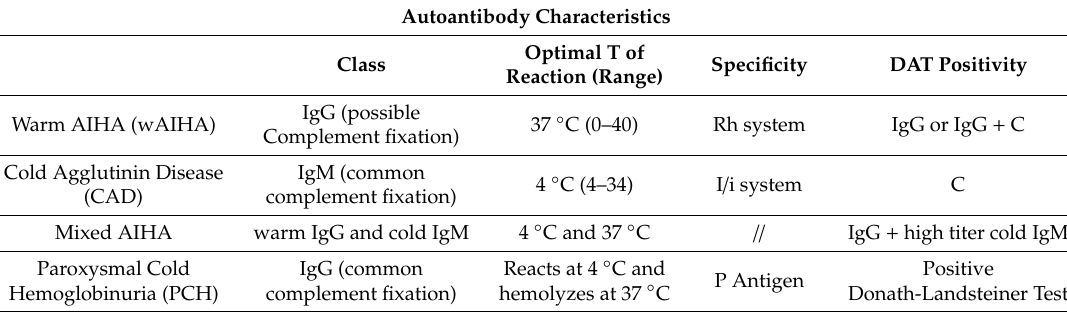
Table 1. Autoimmune hemolytic anemia (AIHA):